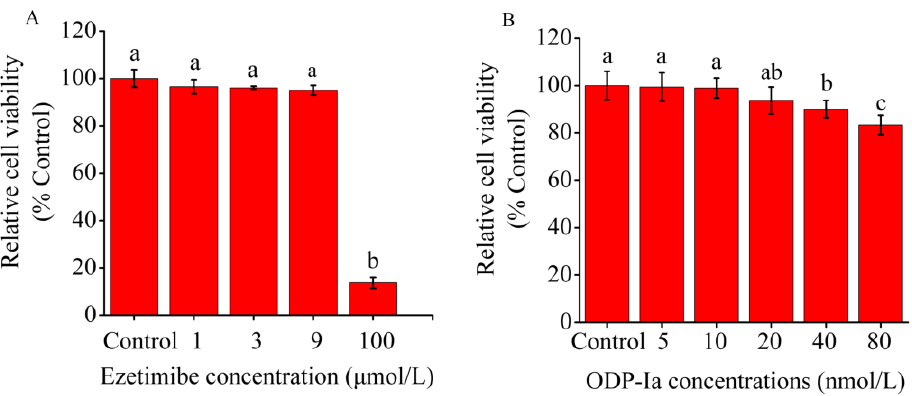
Figure 2. Effect of ODP-Ia and ezetimibe on THP-1 macrophage-derived foam cell viability, as de- termined through MTT analysis. Values are mean ± SD, n = 5. ( A ) ODP-Ia. ( B ) Ezetimibe. Different superscript letters indicate multiple comparisons with significant differences (SNK-q test, p < 0.05).